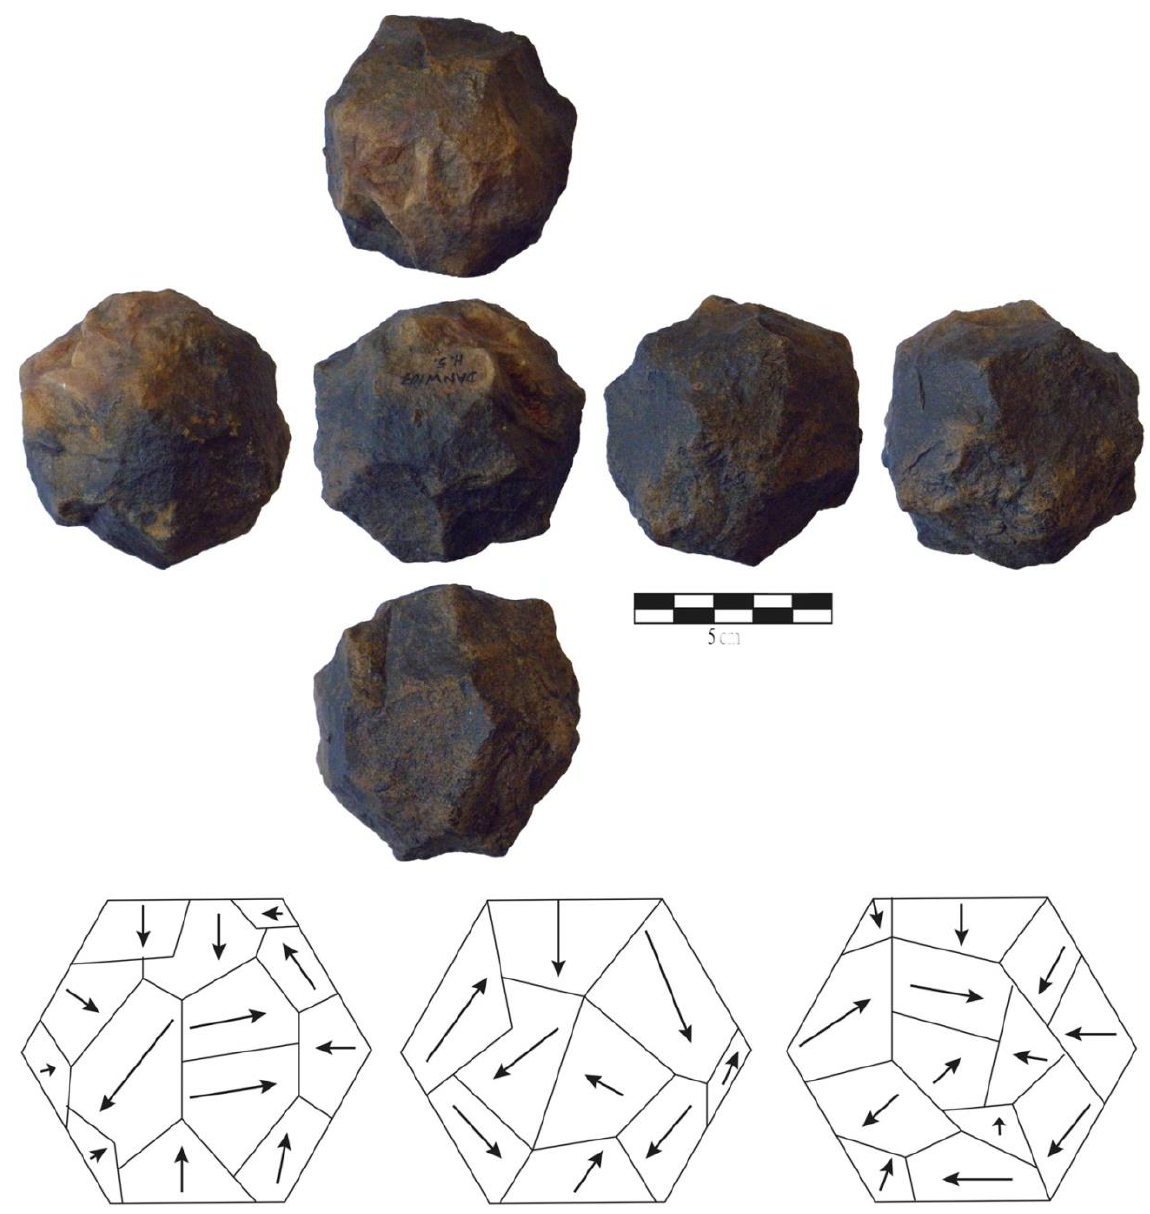
Figure 11. Diacritic scheme of a